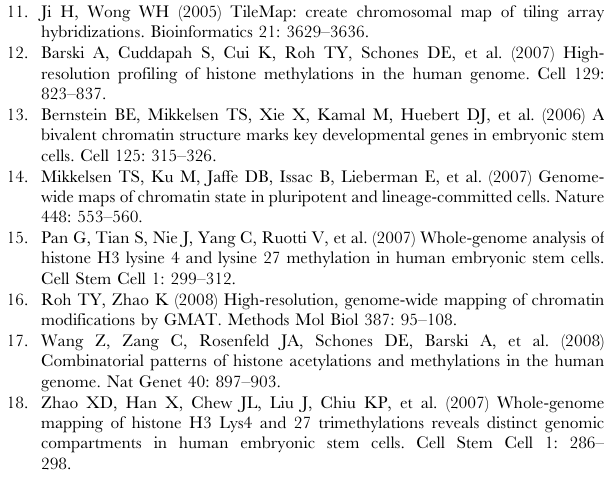
Table S3 Primer sequences.